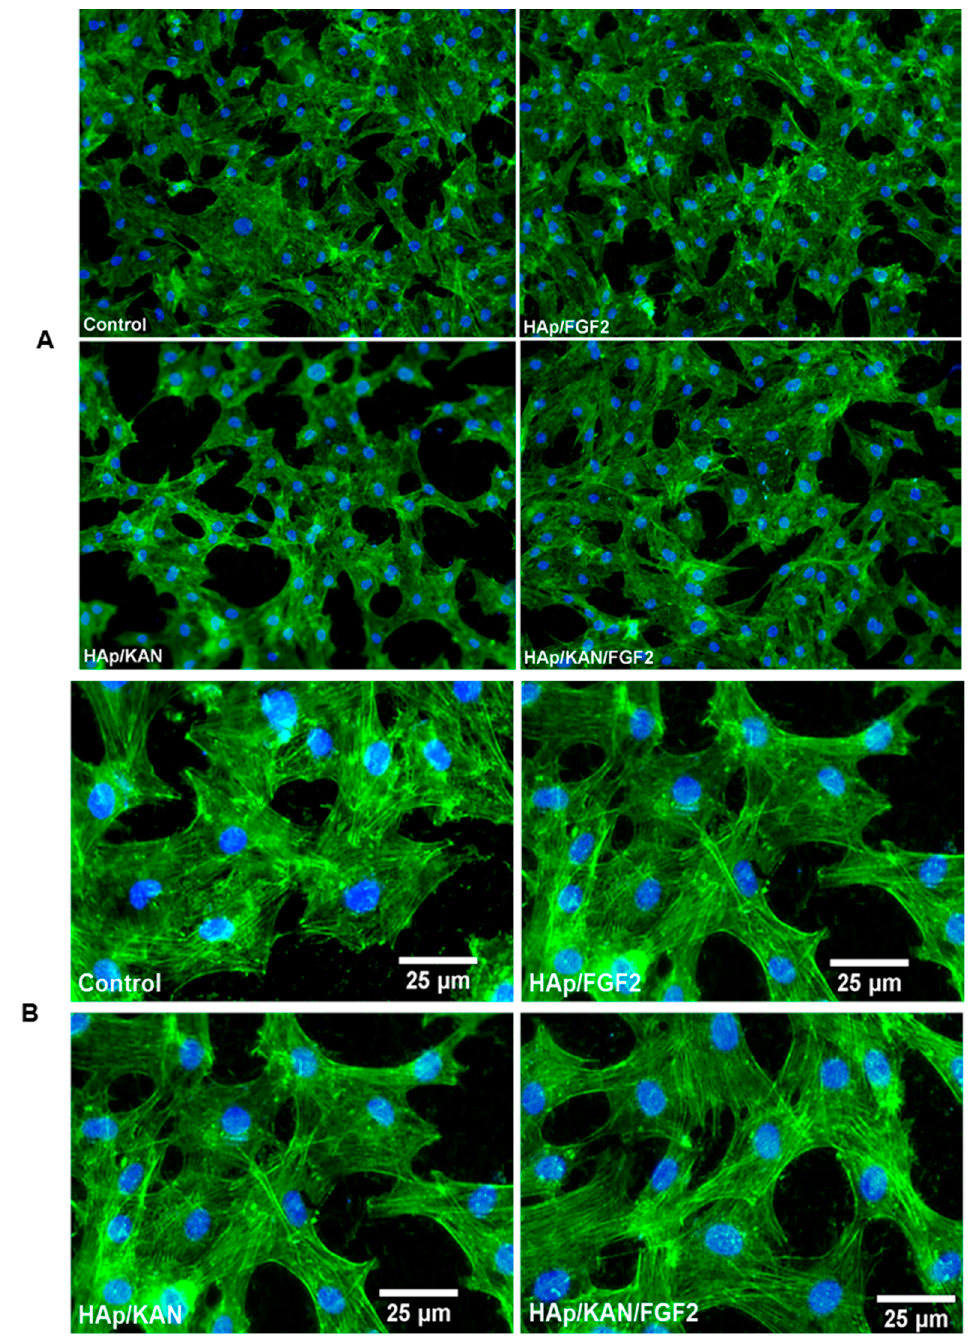
Figure 7. Fluorescence micrographs of osteoblastic cells cultured for 24 h on control and Ti modified with HAp/KAN, HAp/FGF2 and HAp/KAN/FGF2 coatings: ( A ) low magnification with 20× objective and ( B ) high magnification .